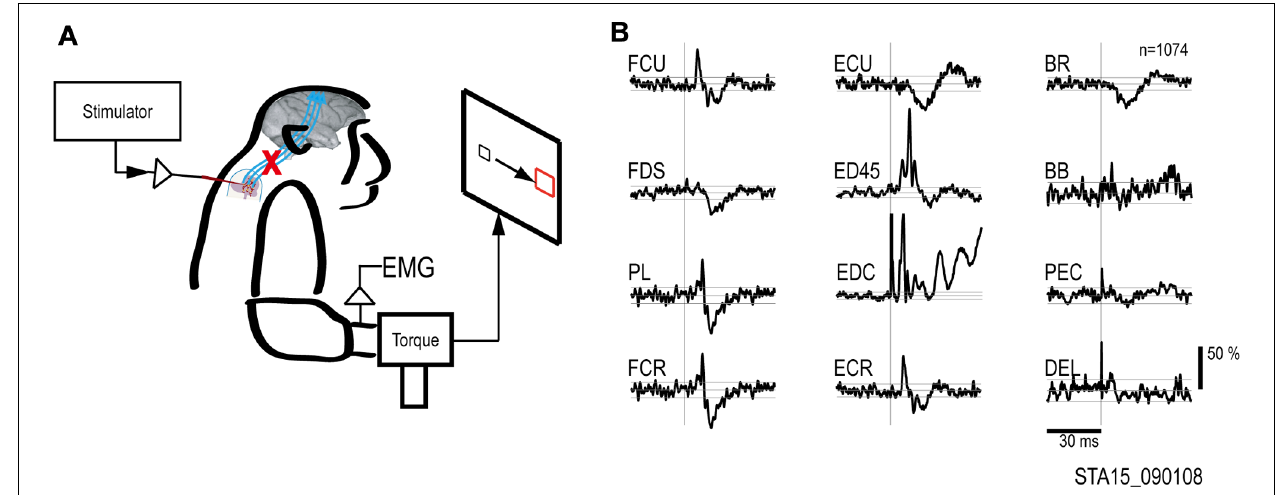
EMGs were recorded from: flexor carpi ulnaris (FCU), flexor digitorum superficialis (FDS), palmaris longus (PL), flexor carpi radialis (FCR), extensor carpi ulnaris (ECU), extensor digitorum 4 and 5 (ED45), extensor digitorum communis (EDC), extensor carpi radialis (ECR), brachioradialis (BR), biceps brachii (BB), pectoralis (PEC), and deltoid